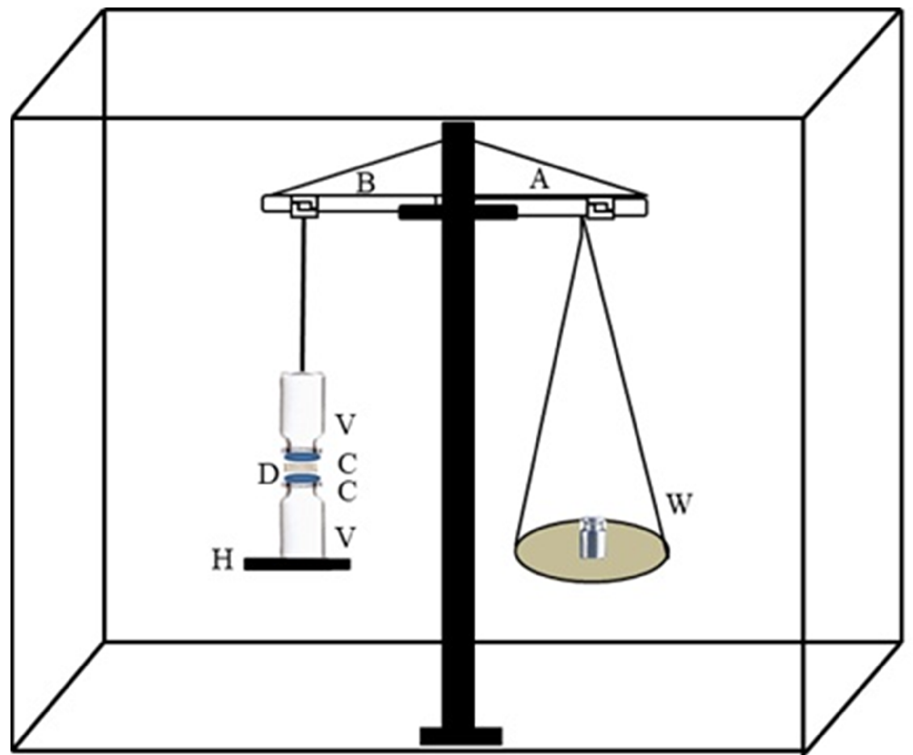
Figure 2. Mucoadhesive force measurement apparatus. A is the modified beam balance, B is the arm attached to the vial, V is glass vials, C is mucosal membranes, H is the height adjustment pan, W is the weights used to detach vials, and D is the hydrogel disc.